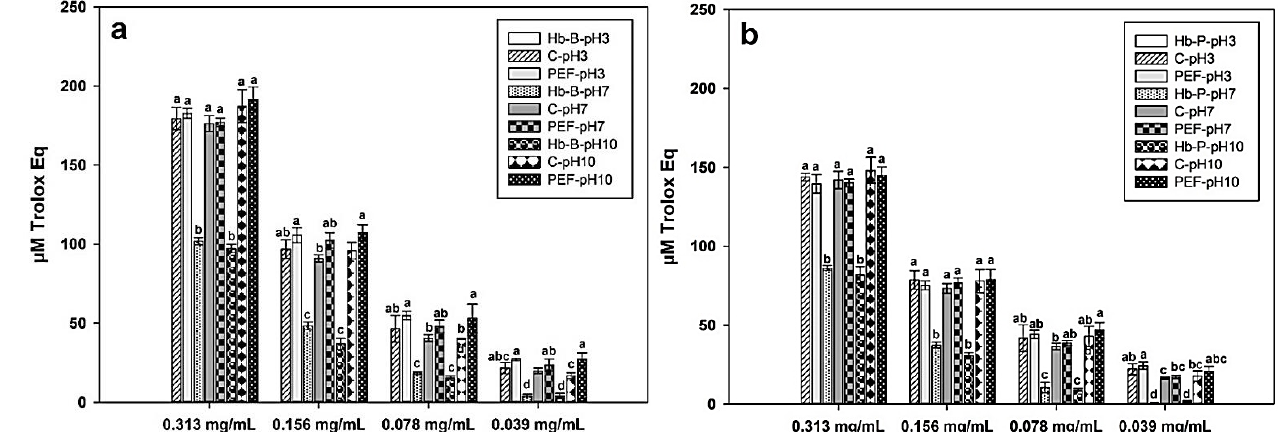
Figure 6. Antioxidant capacity of bovine ( a ) and porcine ( b ) hemoglobin hydrolysates obtained by the ORAC test (µM Trolox Eq) in untreated (C, control) and treated with PEFs at different concentrations. Hb-B and Hb-P indicate native bovine and porcine hemoglobin, respectively. Native Hb-B and Hb-P controls at pH 3 were not determined since they were not soluble in sodium phosphate buffer. Values with different lowercase letters within the same concentration are significantly different (Tukey test at 5%).